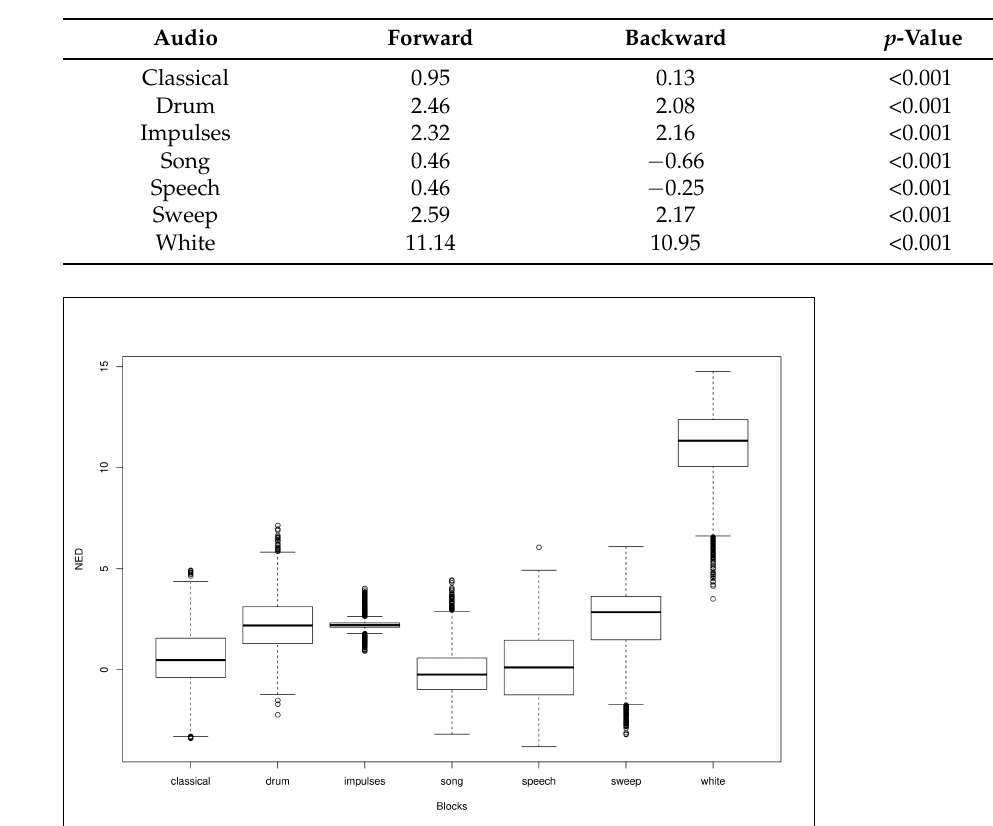
Figure 7. Boxplot of NED for congruent readings.